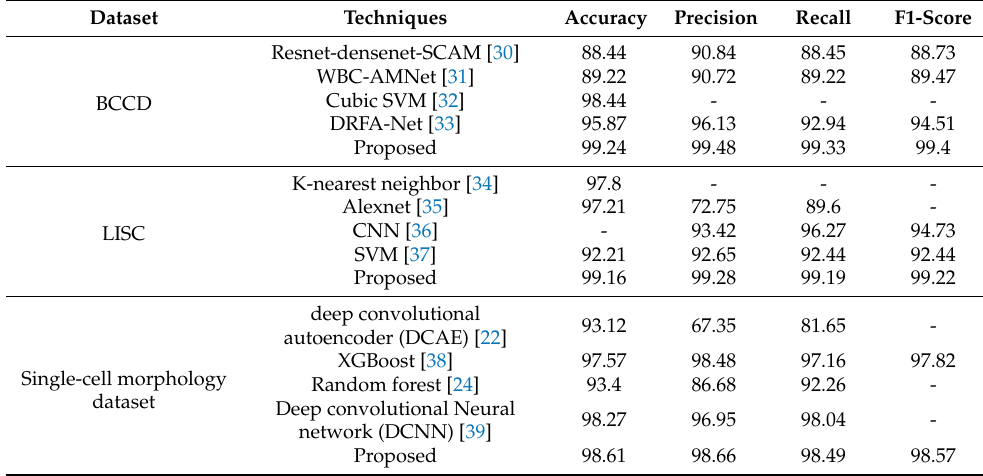
Table 6. Comparison of the proposed approach with existing techniques on three datasets.